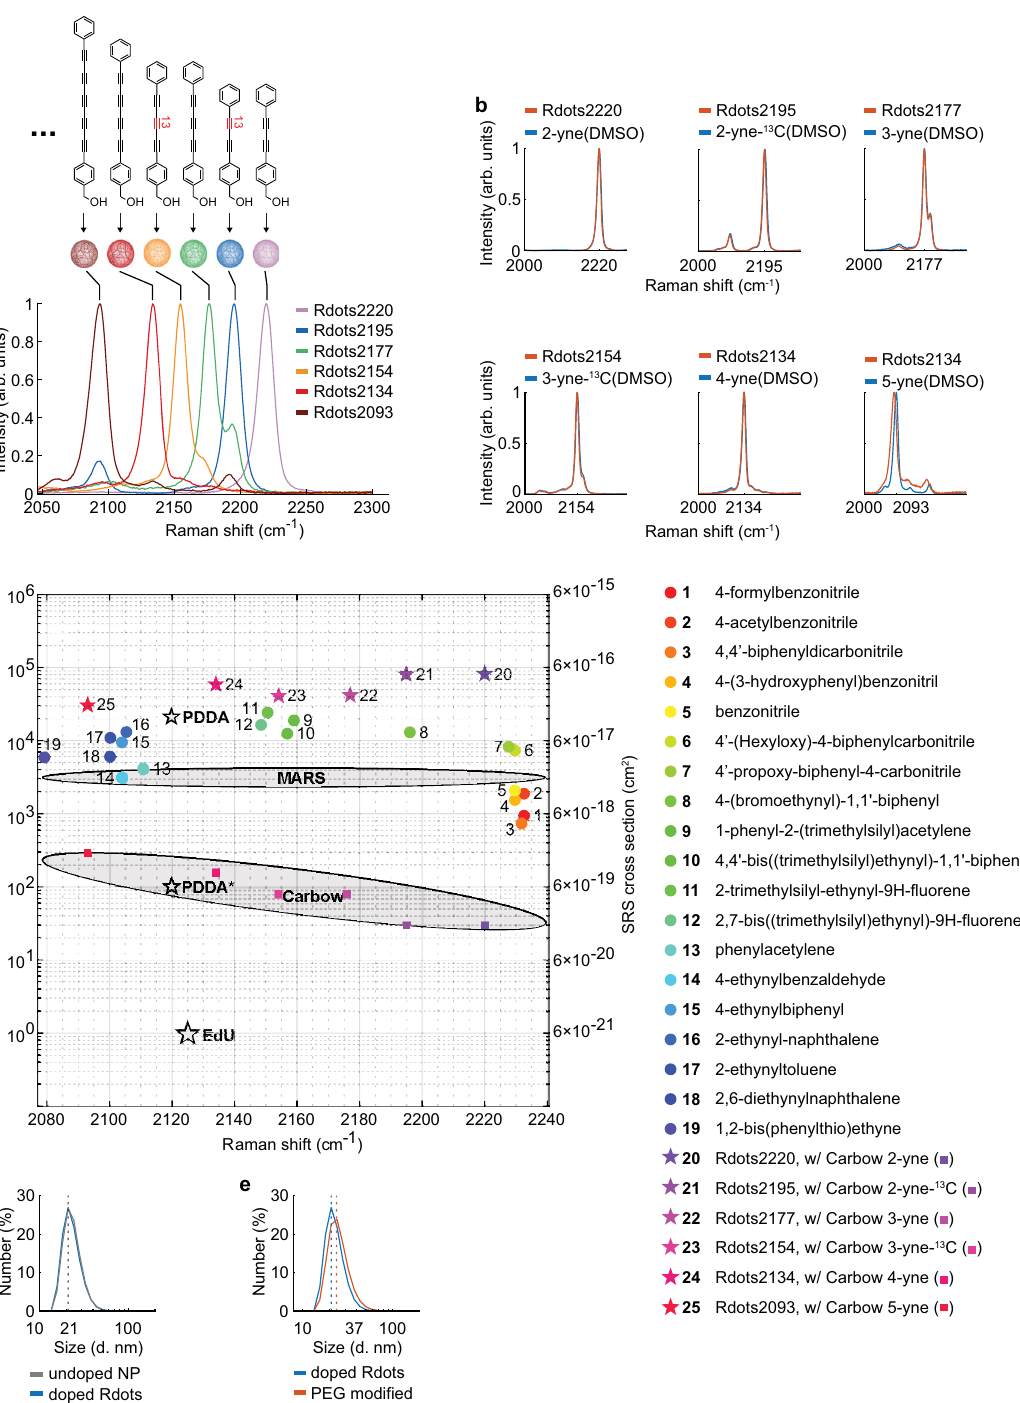
10010 37 Size (d.